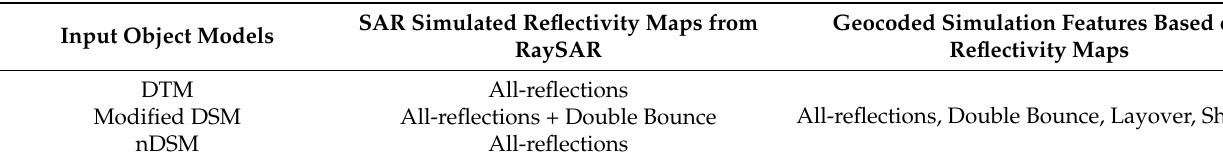
Table 3. SAR simulation outputs.